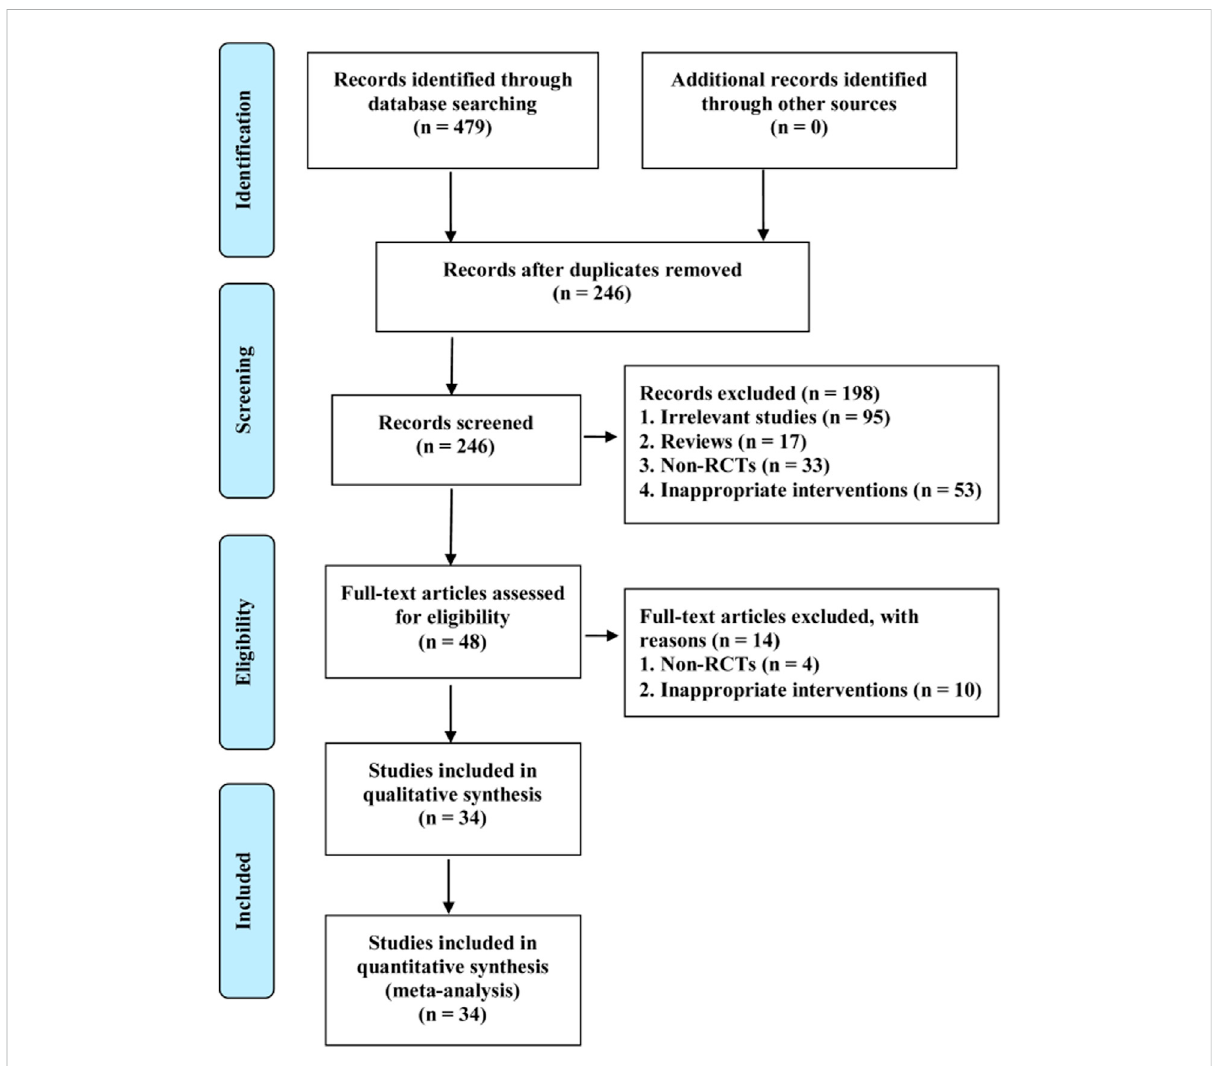
FIGURE 1 PRISMA fl ow diagram of study retrieval and